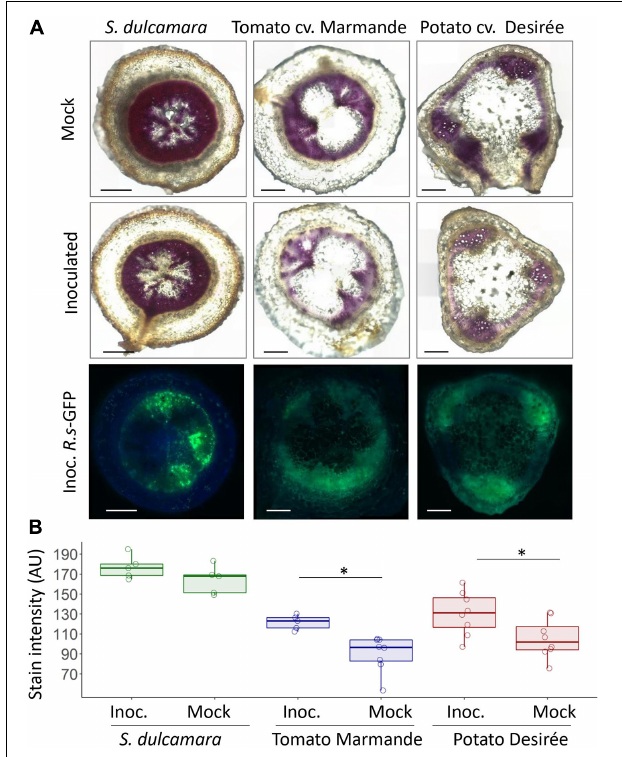
FIGURE 5 | Lignification of S. dulcamara , Tomato cv. Marmande and S. tuberosum cv. Desirée tissues upon R. solanacearum infection. (A) Representative composed images of S. dulcamara , tomato, and potato taproot transversal sections obtained 9 days after inoculation with R. solanacearum- GFP or mock treatment. First and second row: microscope bright-field images after lignin staining with phloroglucinol HCl (magenta colouration). Third row: fluorescence microscopy images after inoculation to assess the extent of bacterial colonisation. Images were obtained using a Leica DM6 microscope. Scale bars indicate 0.5 mm. (B) Quantification of the phloroglucinol HCL stain -indicative of lignin content- in the vascular area from the images shown in A performed with the ImageJ software. ∗ indicates statistical differences ( p -value < 0.05; T -student significant test α =